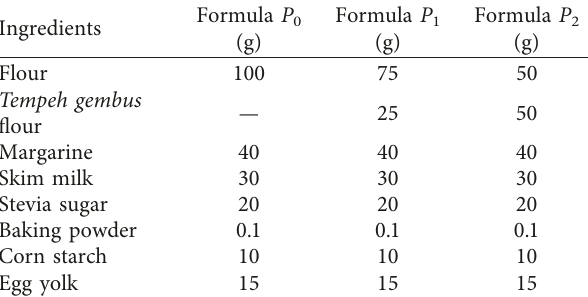
Table 1: Cookies’ formulation with tempeh gembus flour